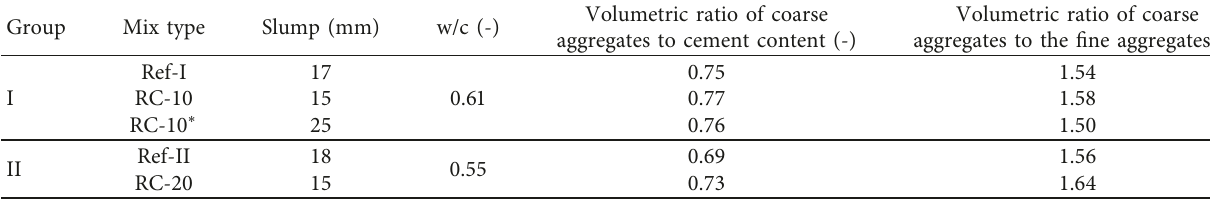
Table 4: Slump and volumetric ratios of coarse aggregates to cement content and coarse aggregates to fine aggregates of the concretes. Group